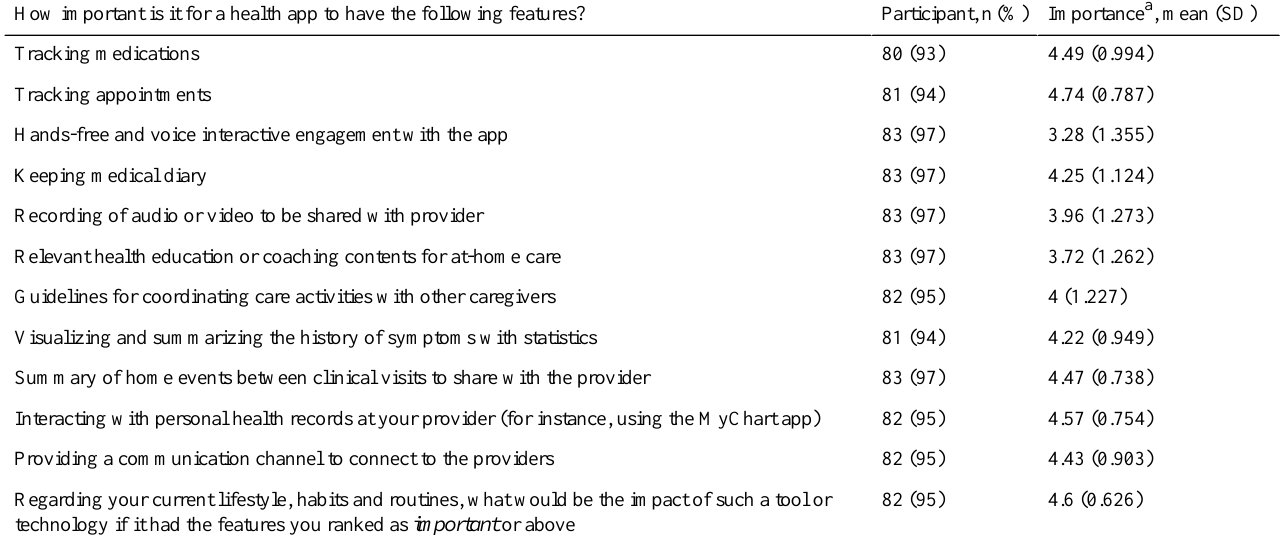
Table 2. Ideal health app